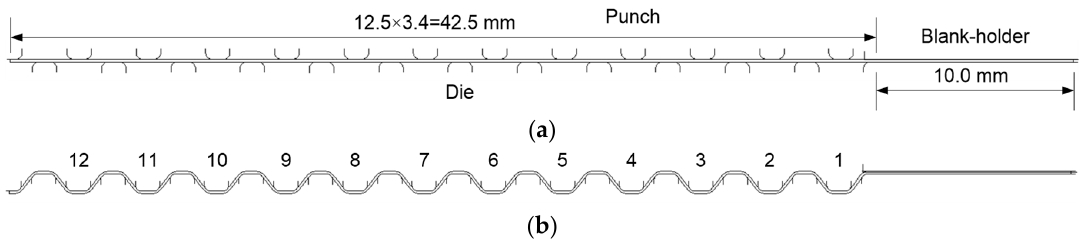
Figure 6. Finite element model (plane strain conditions and half width) of a stamped BPP composed by 25 parallel channels: ( a ) initial position; ( b ) final configuration. Table 2. Reference values for the main dimensions of the forming tools (punch and die) adopted in the analysis of the straight channel section.